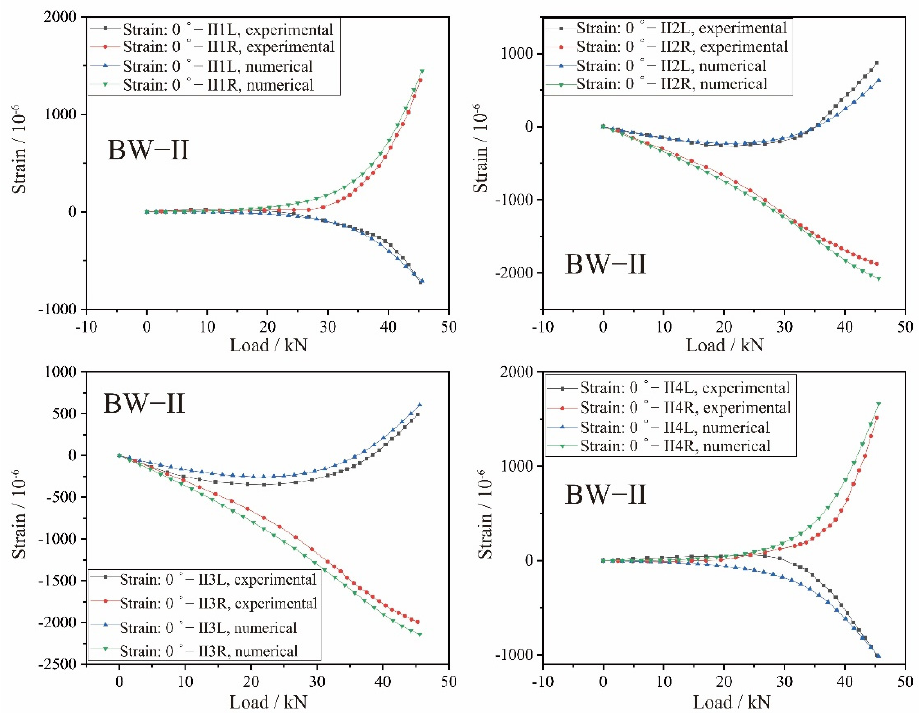
Figure 29. Comparison between the experimental and numerical strain-load curves for the composite beam of BW-II.